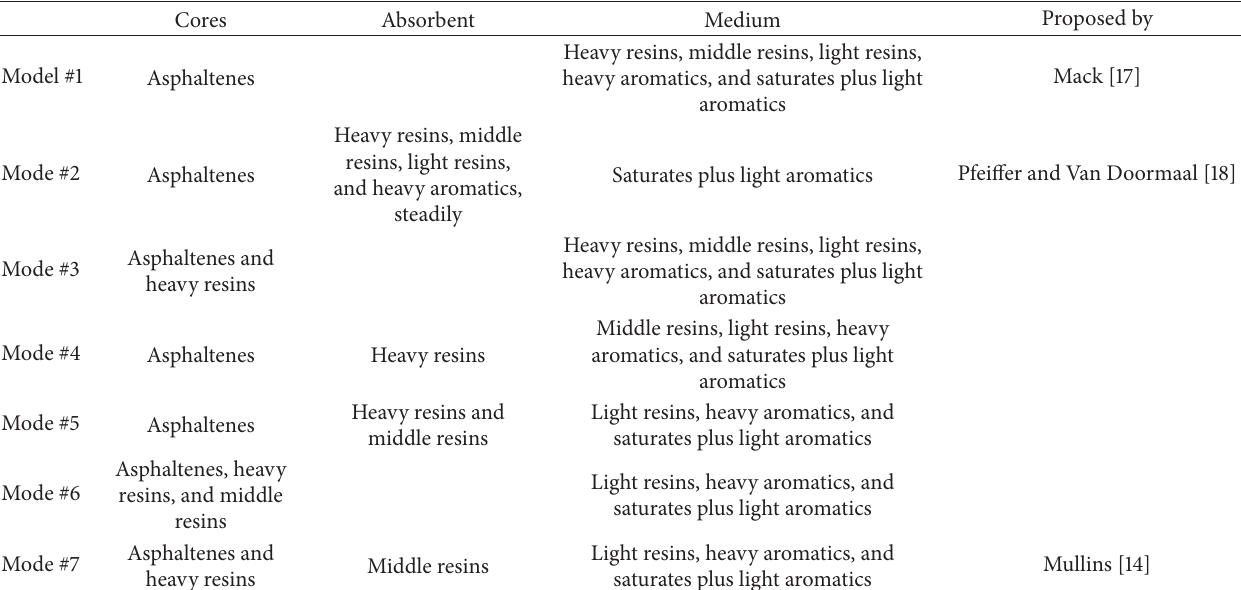
Table 4: The suggested colloidal model.